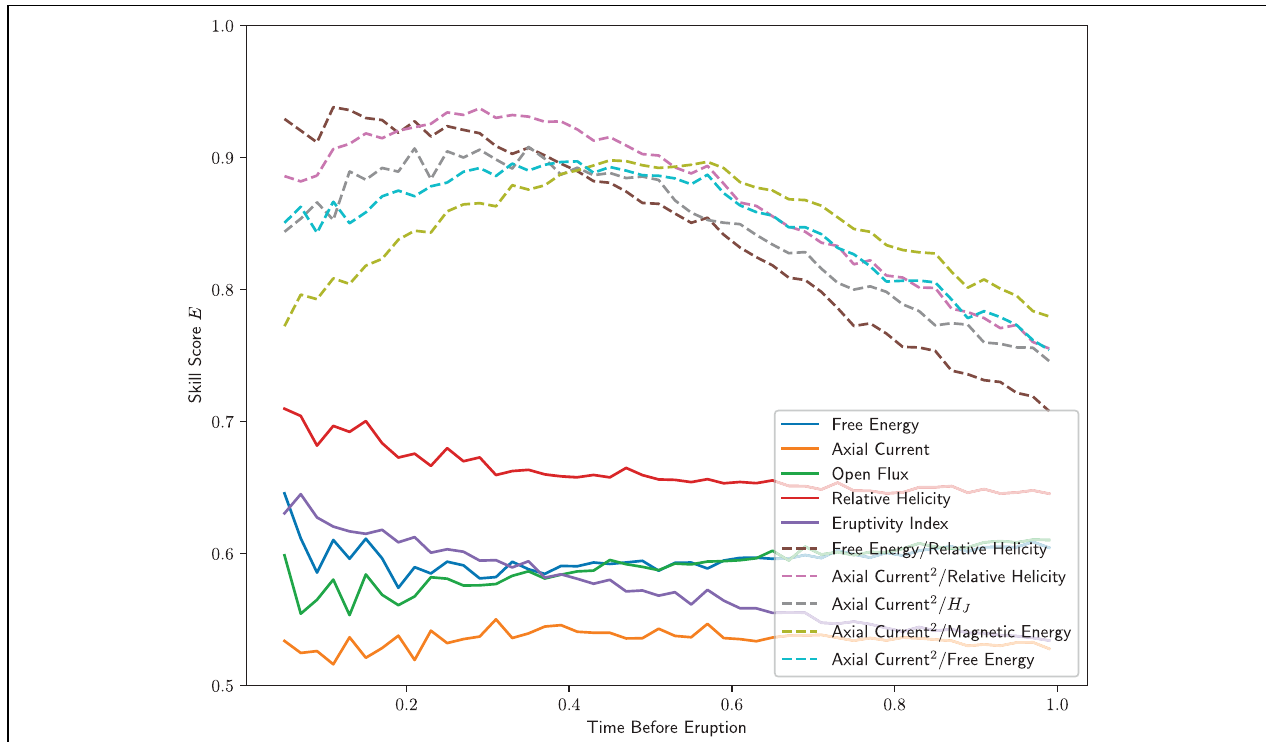
FIGURE 10 | Variation of the skill scores for each of the measured quantities, depending on the time cutoff within which an eruption must occur. The raw diagnostics and eruptivity index are plotted as solid lines, and the ratios are plotted as dashed lines.